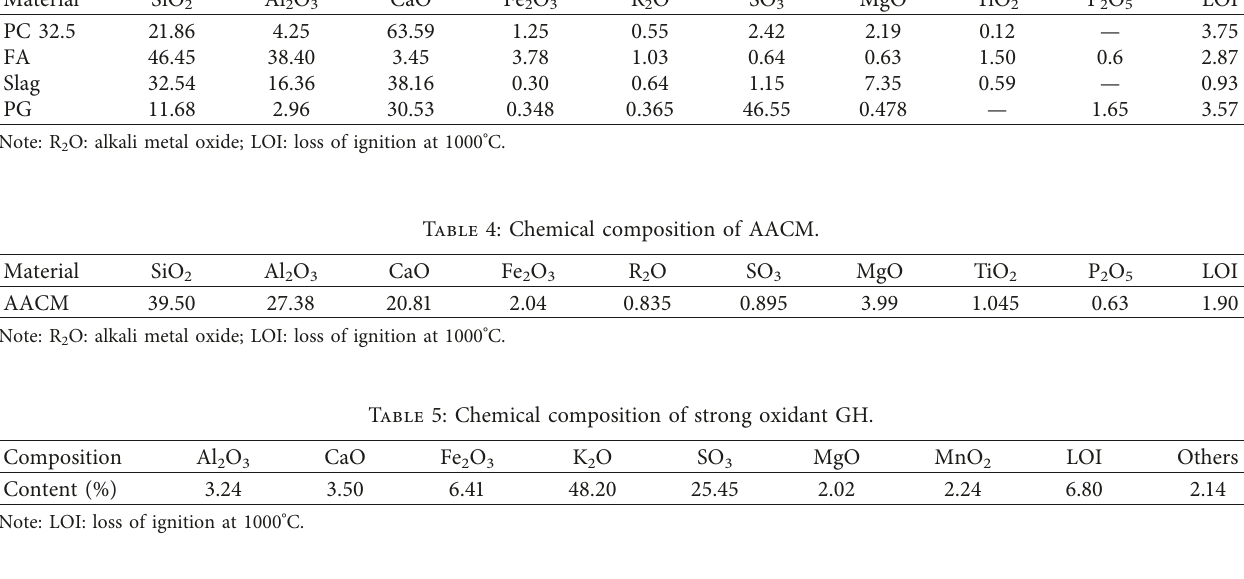
Table 6: Nomenclature and mixing design for